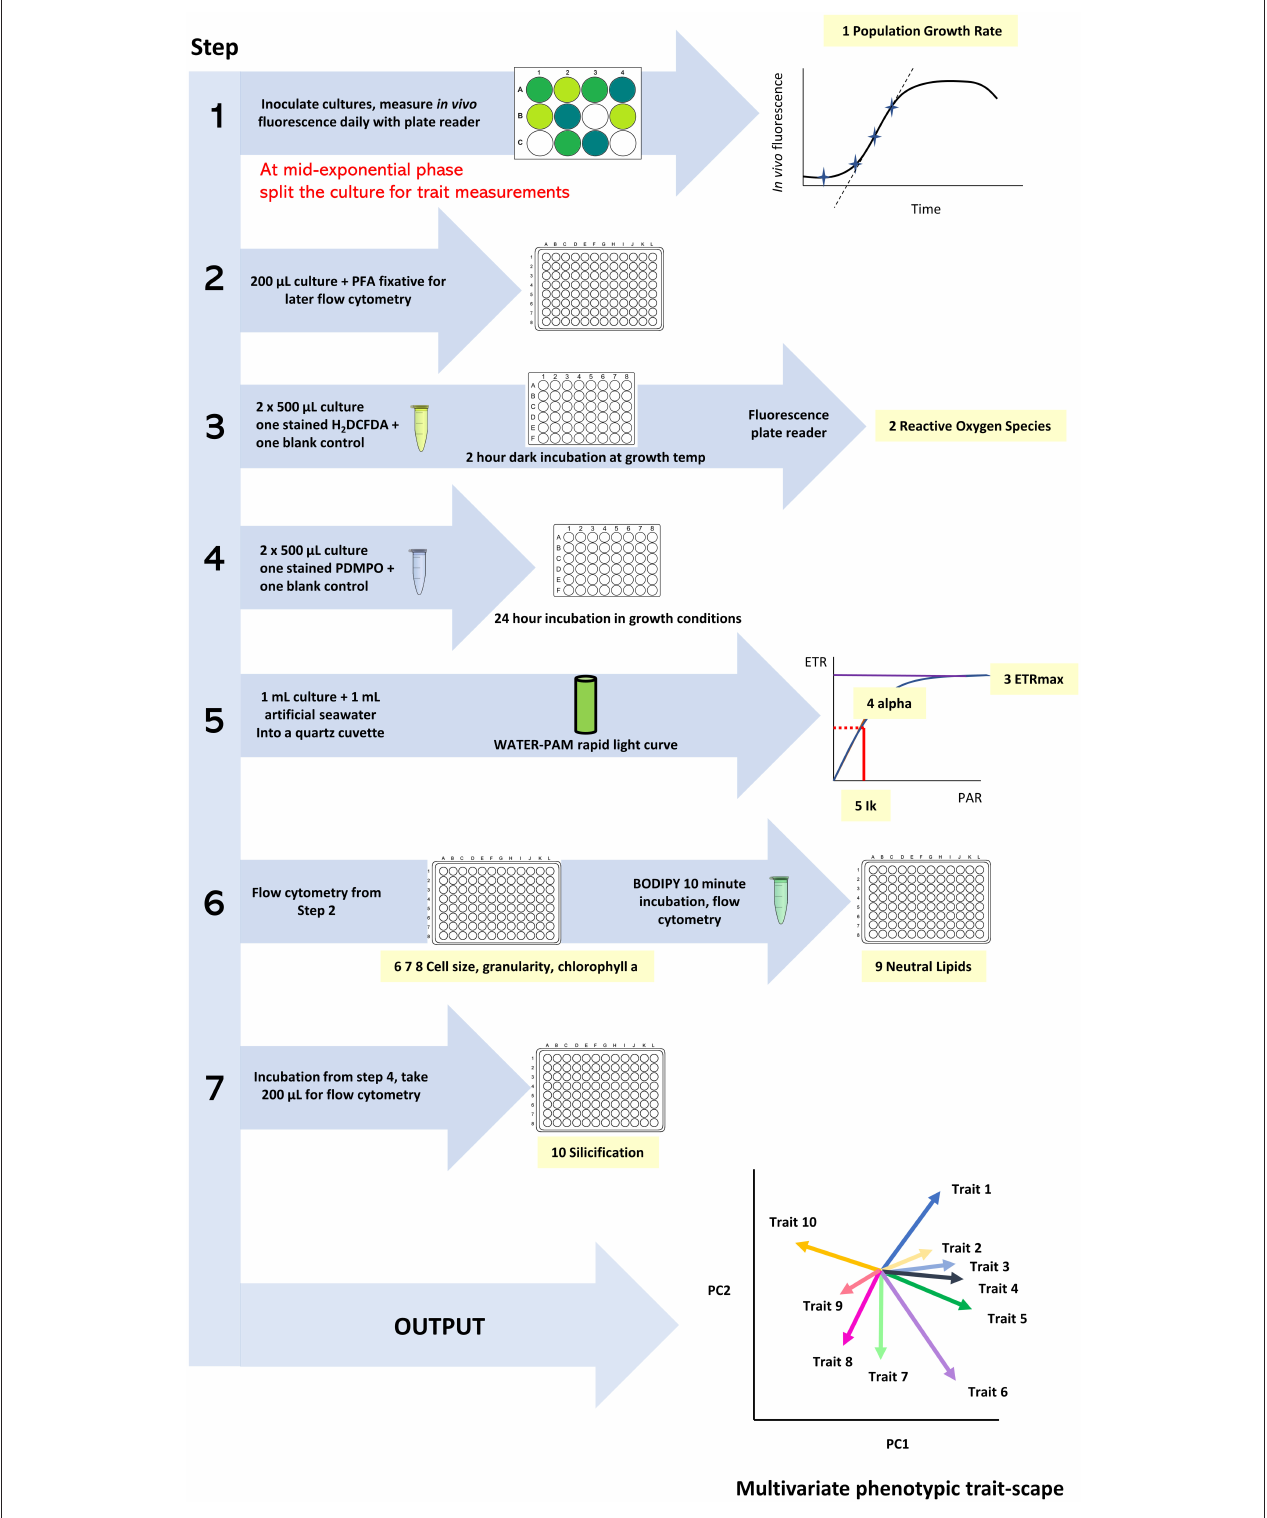
FIGURE 1 | The workflow of the Quantitative Phenotyping Assay (QPA) outlining the sequence of actions, measurements, and data outcomes.